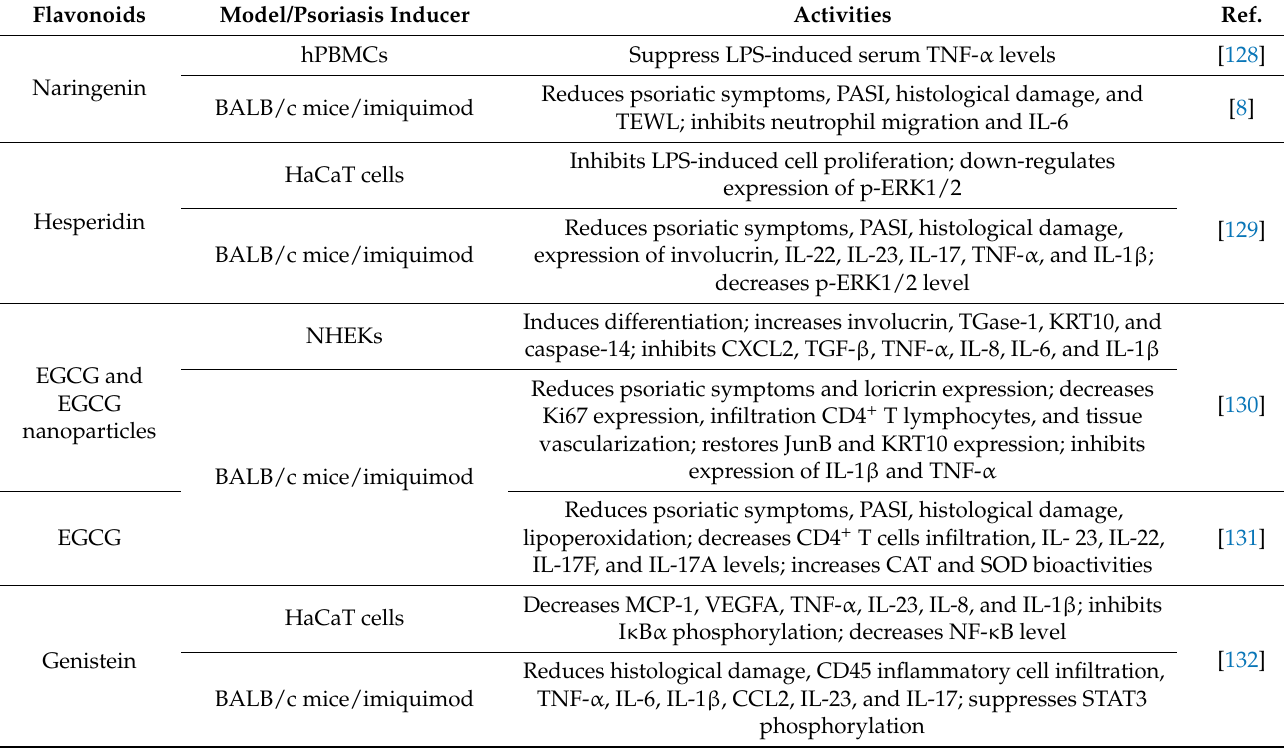
Table 8. Main anti-psoriatic effects of flavanones, flavan-3-ols, and isoflavones in different study models.